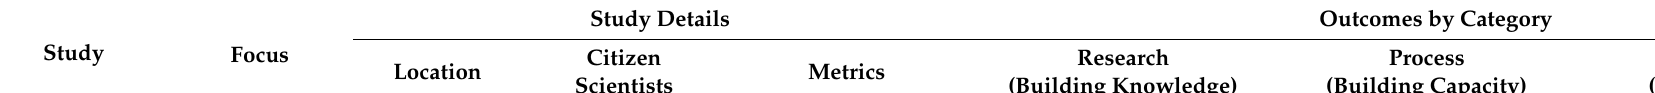
Table 2. Examples of research, process and community outcomes related to healthy eating and the food